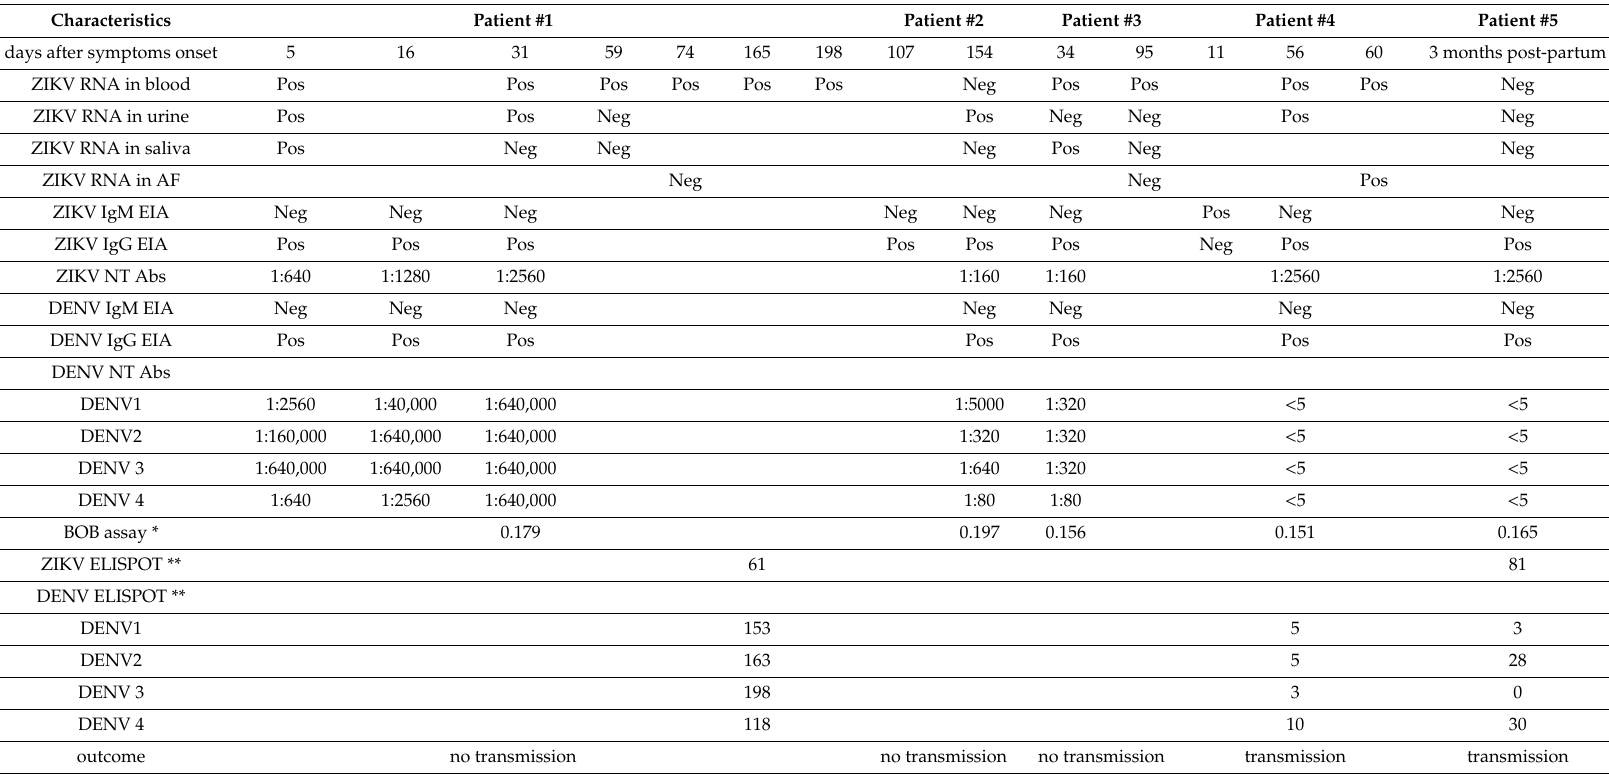
Table 1. Characteristics of all pregnant